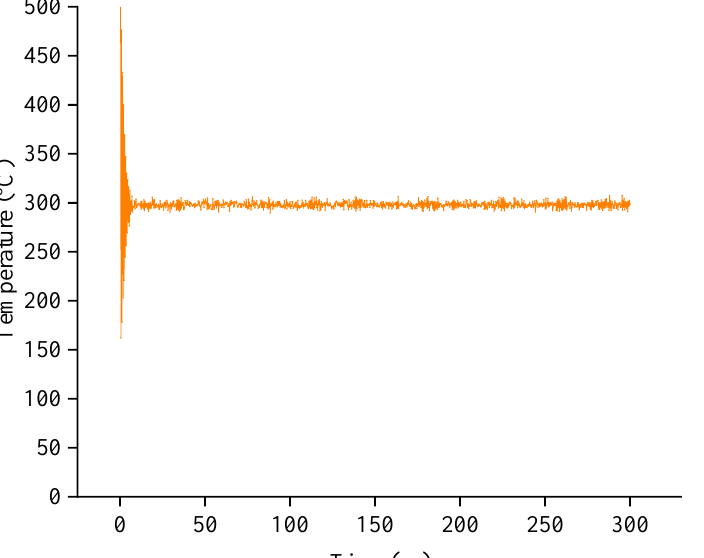
Figure 4. Variation in energy during the NVT dynamics equilibration.